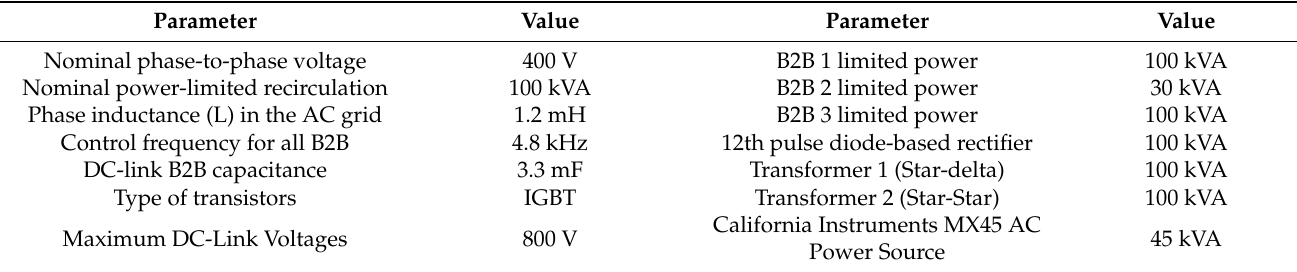
Figure 10. ( a ) 12th pulse diode-based rectifier; ( b ) 100 kW back-to-back converter. Table 2. Test bench characteristics.